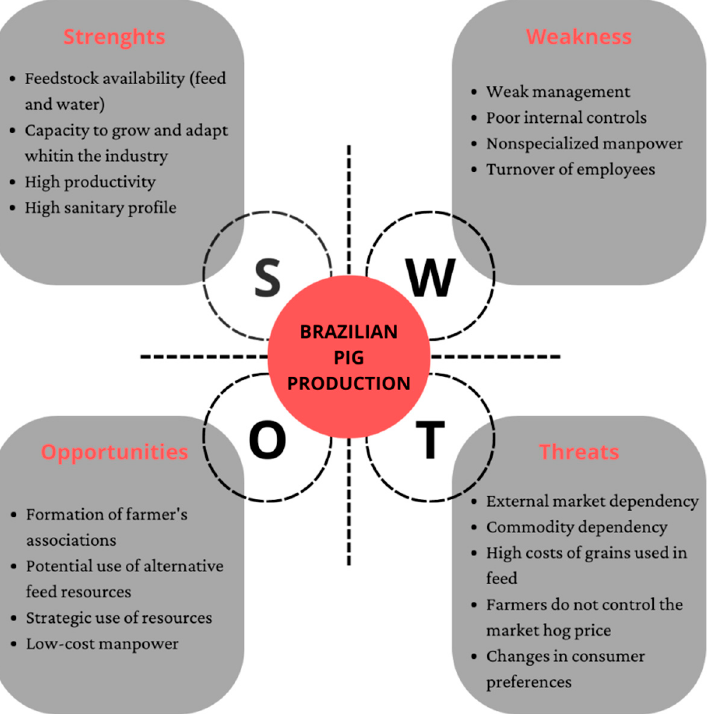
Figure 1. SWOT analysis of Brazilian pig production. Source: Research data.